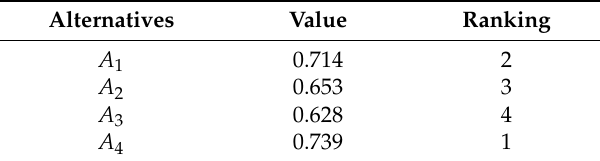
Table 4. The closeness coefficient of the Cloud service alternatives and their rankings.